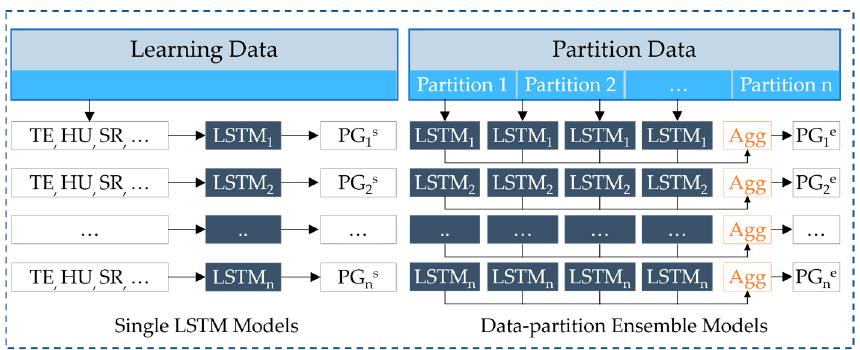
Figure 5. Training structure of the LSTM